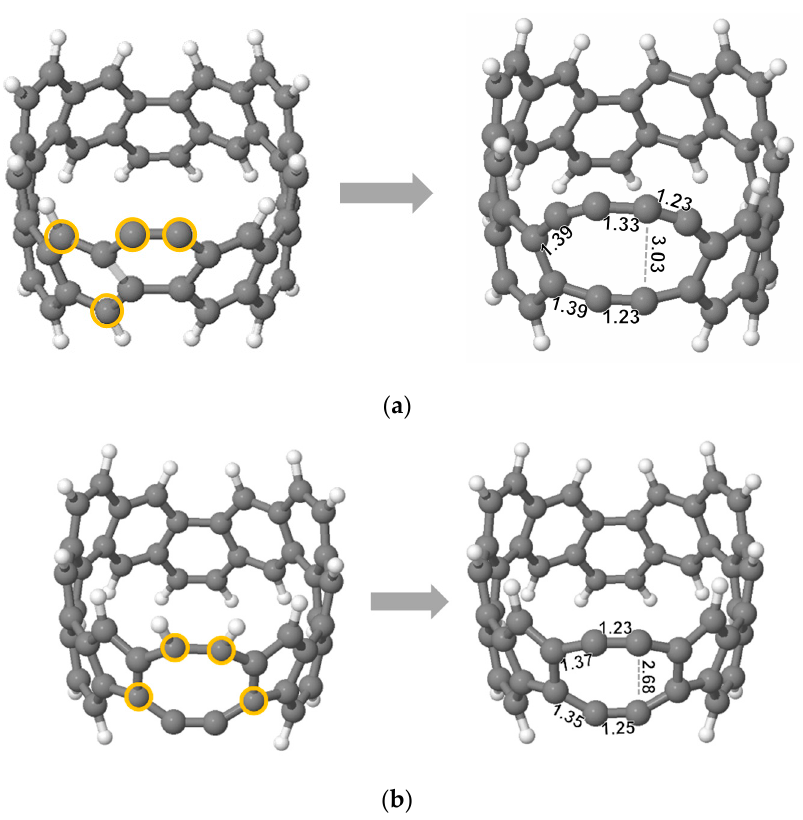
Figure 5. Further 2H loss from C 48 H 22 to C 48 H 20 (dehydrogenated carbon atoms circled in orange), for ( a ) the exterior route and ( b ) the SW-carbyne route. The bond grey-shaded in C 48 H 22 breaks, creating two carbyne chains. Bond-lengths (Å) are symmetric about the two chain centres and for clarity are shown only